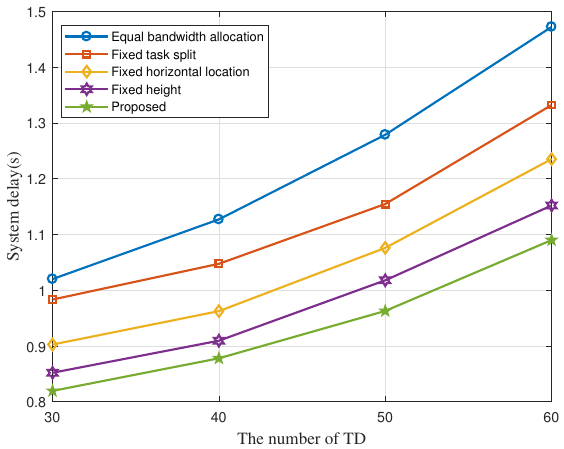
Figure 8. System delay with different number of TDs.